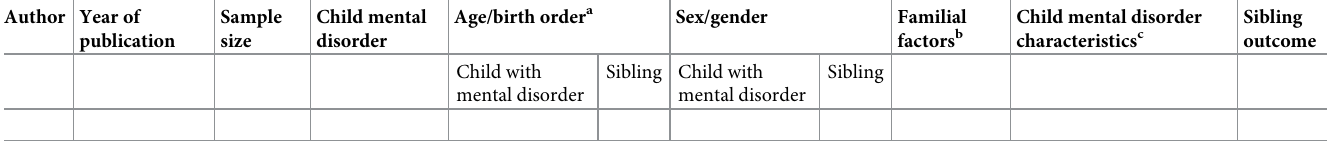
Table 1. Effects of child mental disorders on their siblings.